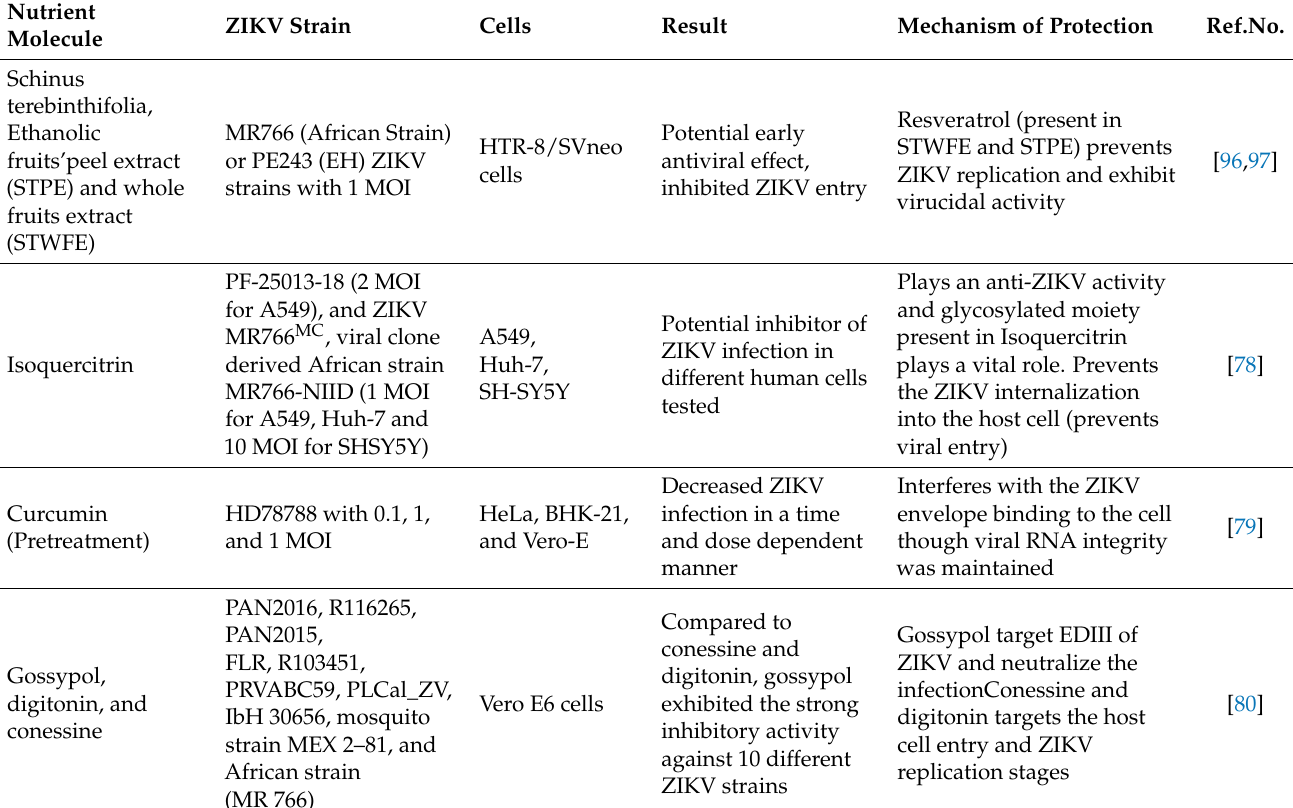
Table 2. List of novel nutrient molecules and mechanism of protection against ZIKV infection. Result Mechanism of Protection